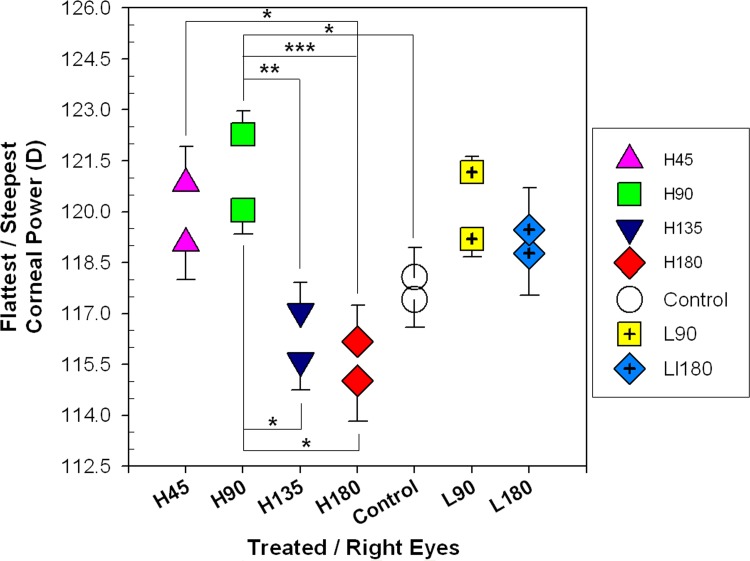
Changes in corneal curvatures in response to optically imposed astigmatism.Comparisons of the steepest (top symbols) and the flattest corneal curvatures (bottom symbols) across the controls and treatment groups at P12 (treated/right eyes data only). The levels of statistical significant difference across the treatment groups (Tukey’s post hoc tests), are indicated by asterisk: * p≤0.05, ** p≤0.01, ***p≤0.001. Although both SK and FK of L90 were not statistically different from others, they showed similar trends as those in H90.